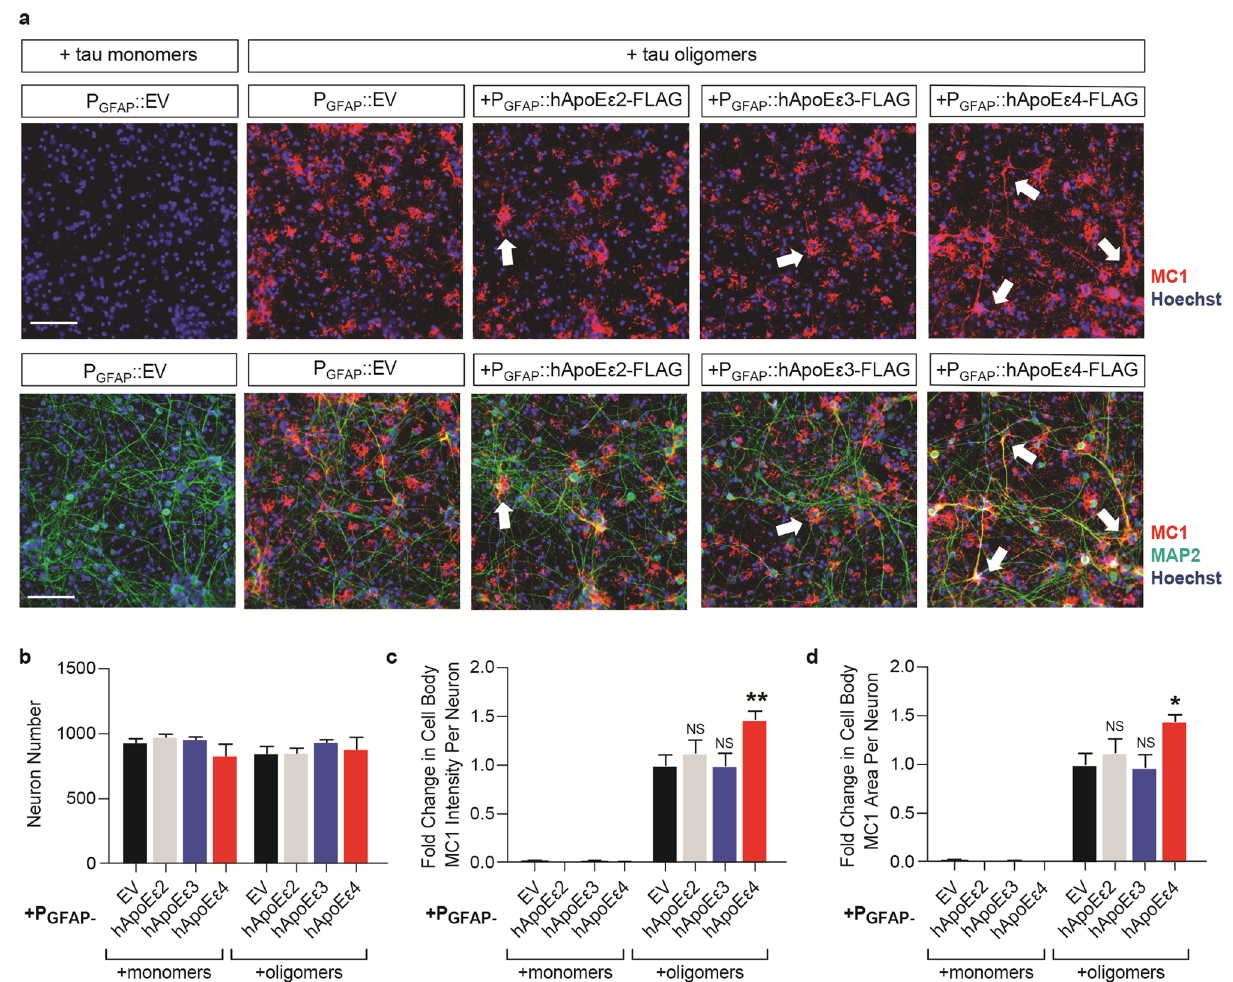
Figure 5. Astrocytic hApoEε4 potentiates MC1 pathology produced by tau oligomers. Scale bar of representative images represents 50 µM. High-content imaging and associated quantification represents data from one independent experiment. (a) Immunocytochemistry of co-cultures five days after addition with 100 nM of tau monomers or tau oligomers. Oligomers were added five days after transduction with the P GFAP construct of interest. Cells were fixed and stained with MC1 to measure tau pathology and MAP2 to label neurons. Hoechst stain was used to label nuclei. Arrowheads highlight examples of MC1-positive cell bodies and neurites. Top panel depicts images without MAP2 imaging overlay to aid in visualization. (b) High-content imaging to quantify MAP2-positive Hoechst-labeled nuclei ( n = 4 wells/group). (c,d) Quantification of MC1 intensity (c) and MC1 area (d) in MAP2-labeled cell bodies ( n = 4 wells/group). Data were normalized to the oligomer-treated P GFAP ::EV group ( n = 4 wells/group). NS not significant, * p < 0.05, ** p < 0.01, Tukey multiple comparisons test following one-way